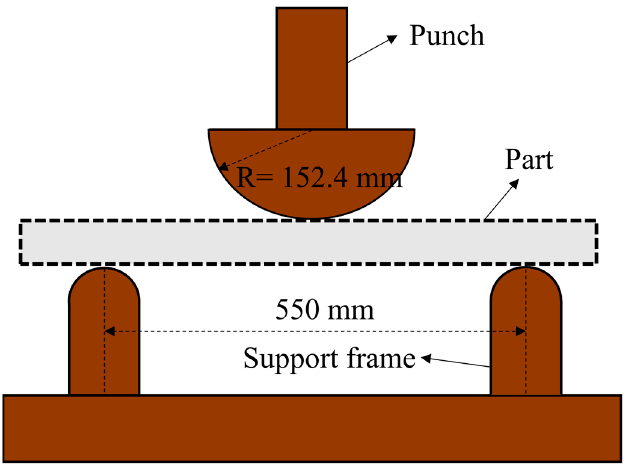
Figure 3. Schematic diagram of component level quasi-static three-point bending tests.